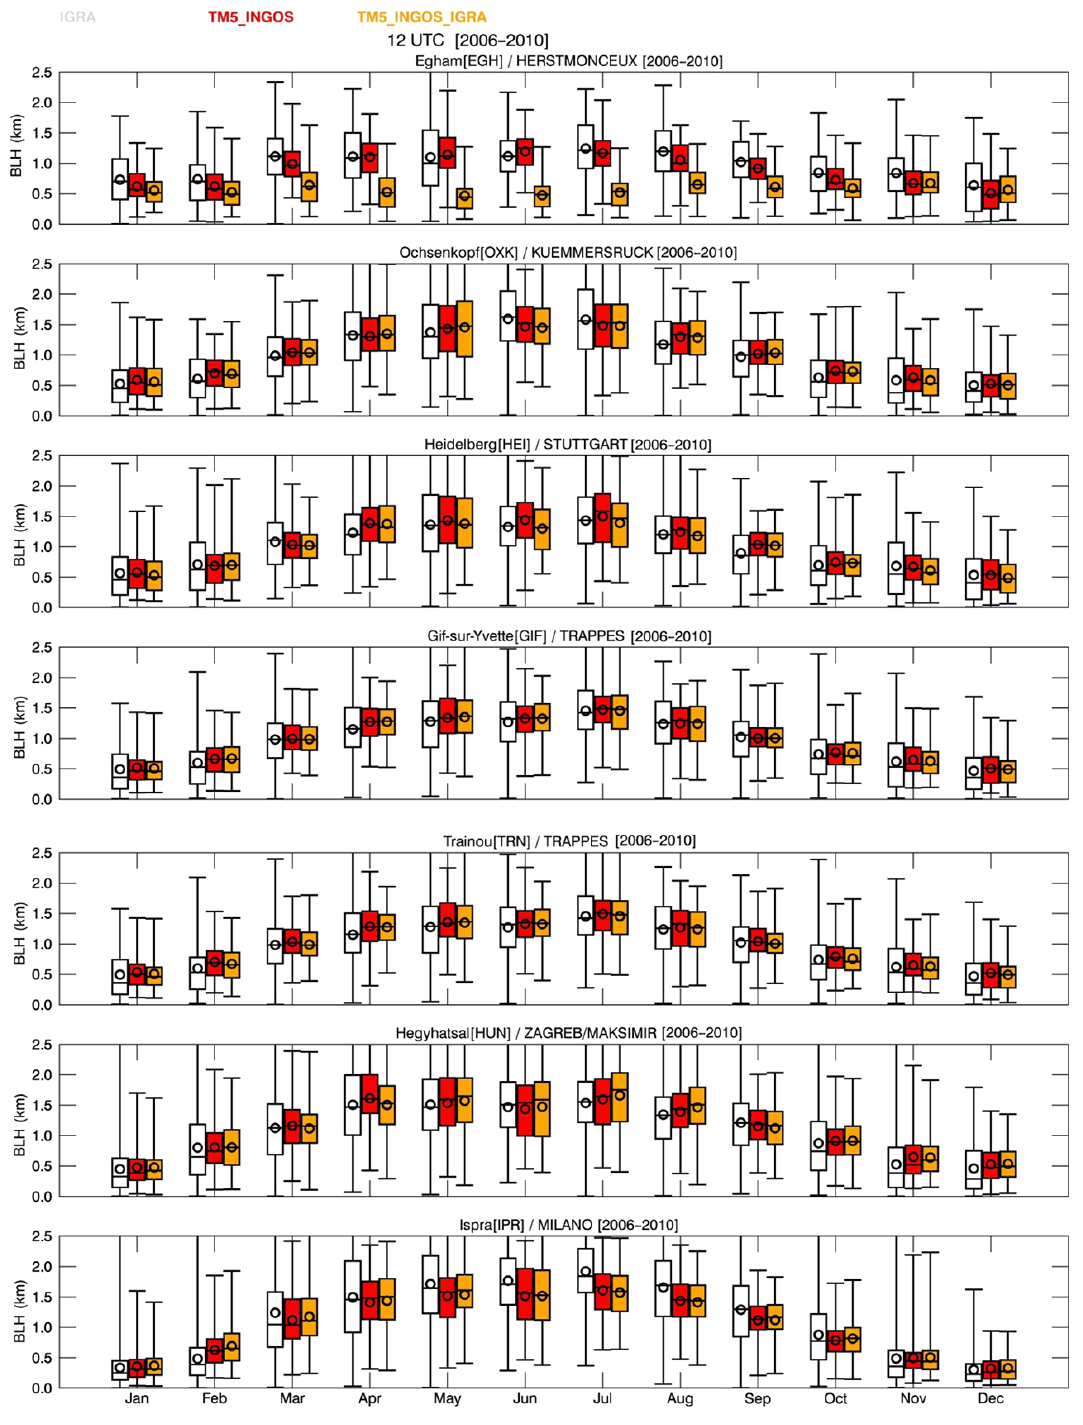
Figure 4. As Fig. 3, but at 12:00UTC.